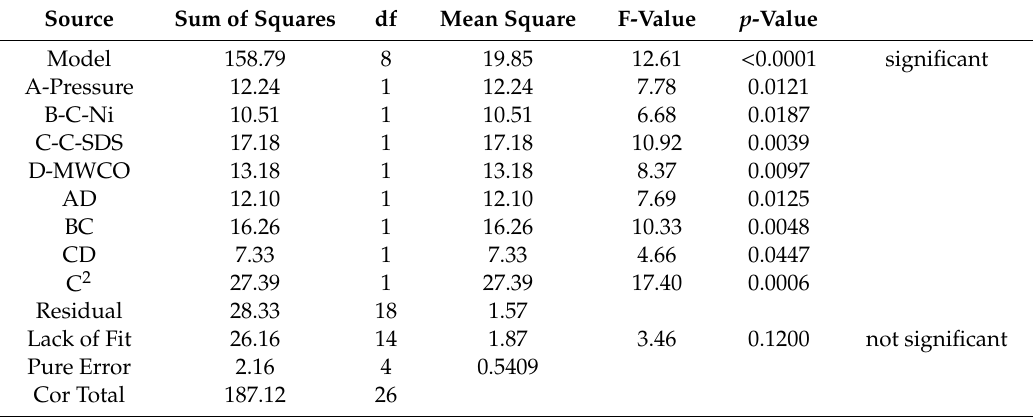
Table 5. ANOVA for reduced quadratic model (response: rejection).